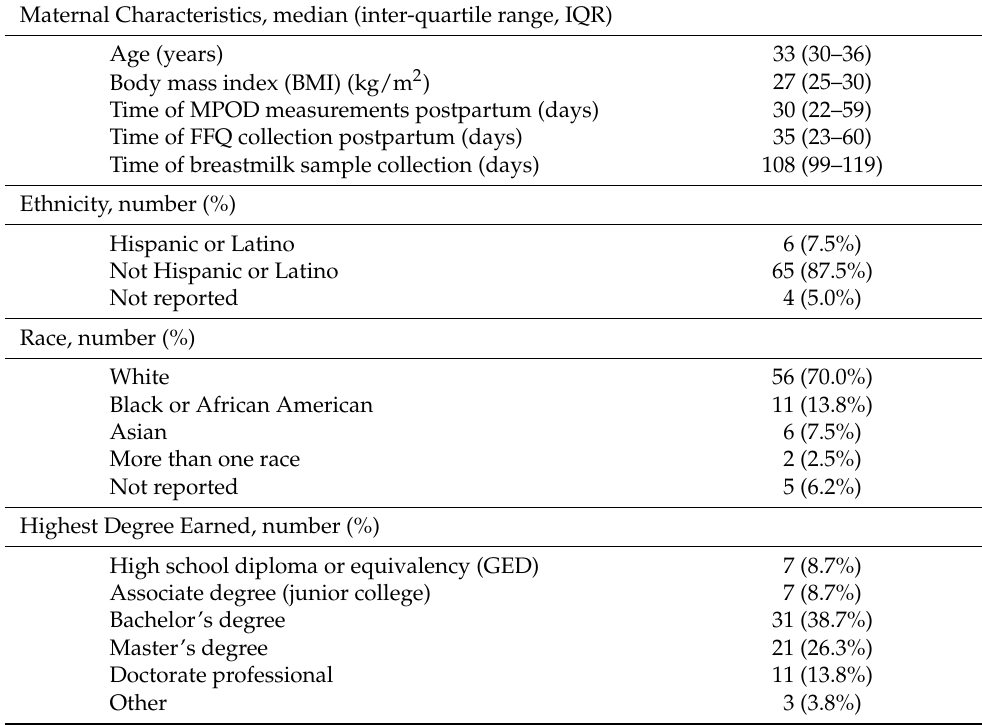
Table 1. Demographics of participants ( N =